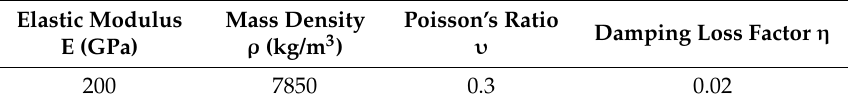
Table 3. Piezoelectric properties of the PZT patch. Table 2. Mechanical properties of the steel interface body.